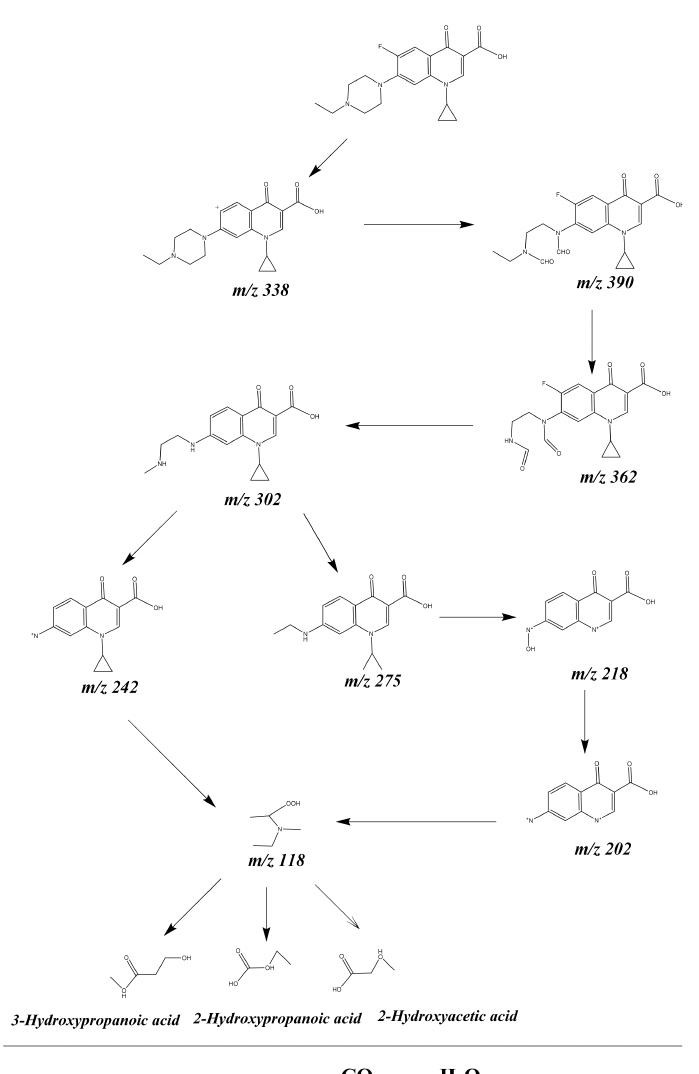
Figure 20. Suggested PCD pathway scheme for ENR under VLGI with EBH as